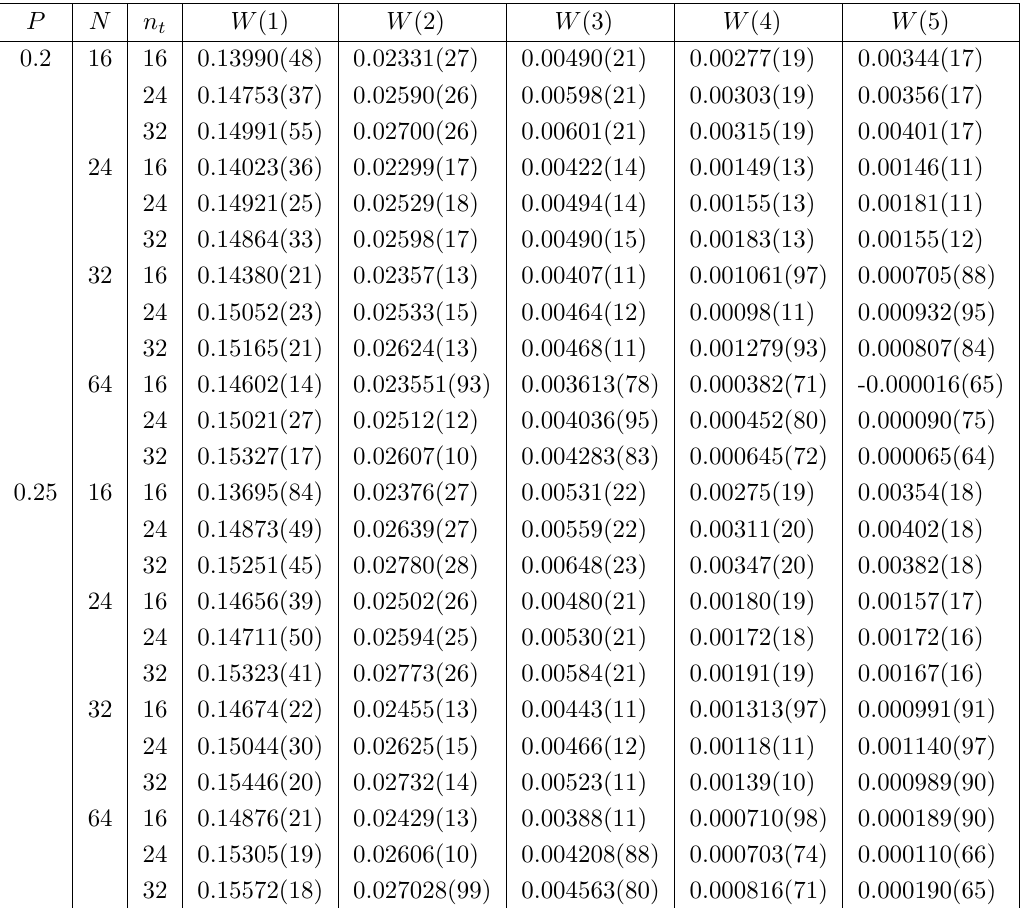
Table 11. W mix for L = 1 , 2 , 3 , 4 , 5 , constrained, T = 0 . 29